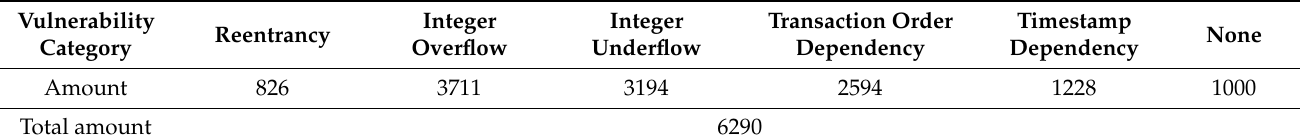
Table 5. Number of smart